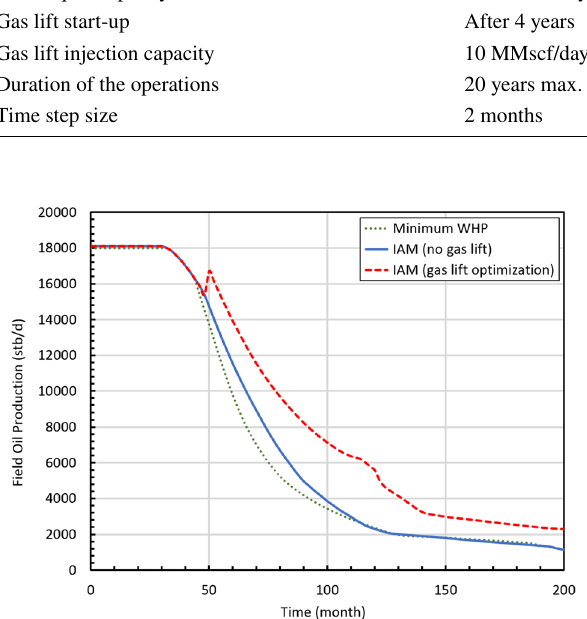
Fig. 9 Comparison of three production forecasts: (1) isolated approach with minimum WHP as boundary condition; (2) integrated approach without gas lift; and (3) integrated approach with gas lift optimization